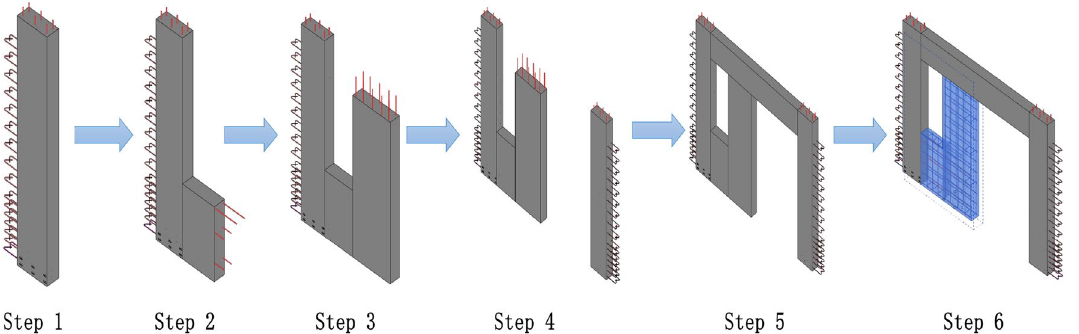
Figure 10. BIM-based parametric module combination